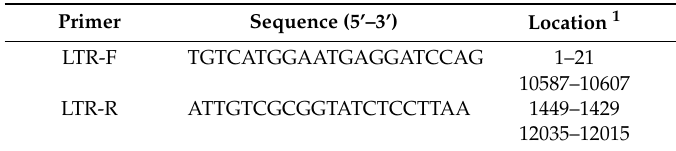
Table 1. Primers used in PCR